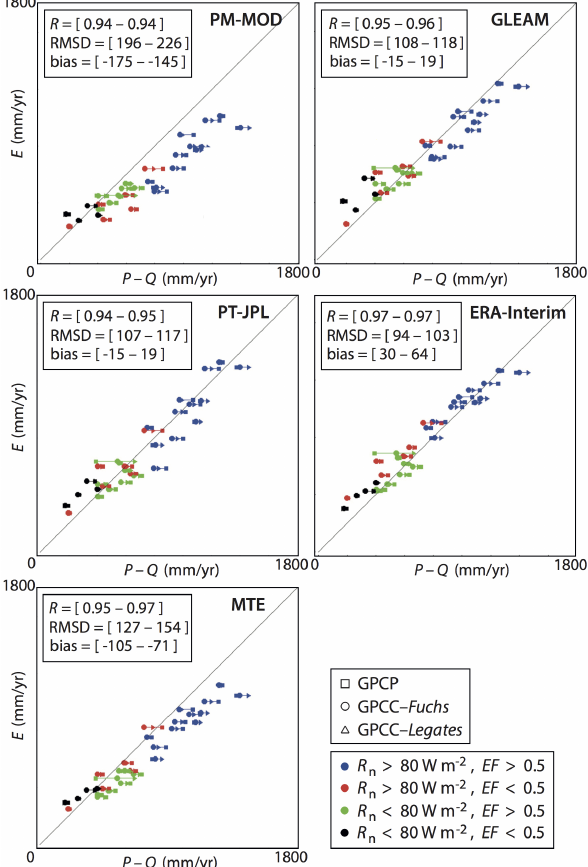
Figure 10. Skill to close catchment water budgets. Correlations between the long-term averages in evaporation from the three WACMOS-ET models and P – Q estimates based on observations from 837 catchments. ERA-Interim and MTE are added for the sake of completeness. Three different precipitation products are consid- ered in the calculation of P – Q : GPCP, GPCC v6 with gauge cor- rection factors from Fuchs et al. (2001), and GPCC v6 with gauge correction factors from Legates and Willmott (1990). The corre- sponding validation statistics are noted within the scatterplots, and the range displayed for each statistical inference derives from the use of the three different precipitation